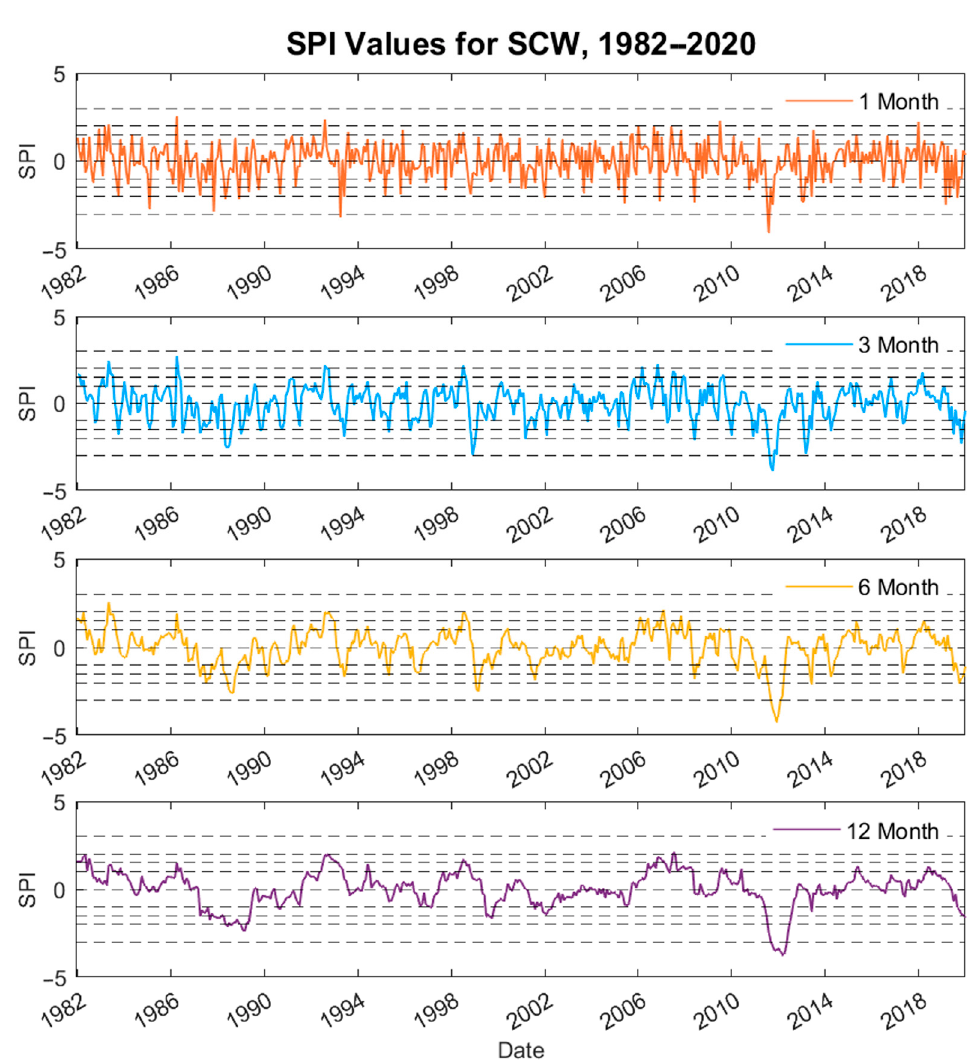
Figure 7. 1 ‐ month, 3 ‐ month, 6 ‐ month, and 12 ‐ month SPI values for SCW plotted over time from Figure 7. 1-month, 3-month, 6-month, and 12-month SPI values for SCW plotted over time from 1982–2020.